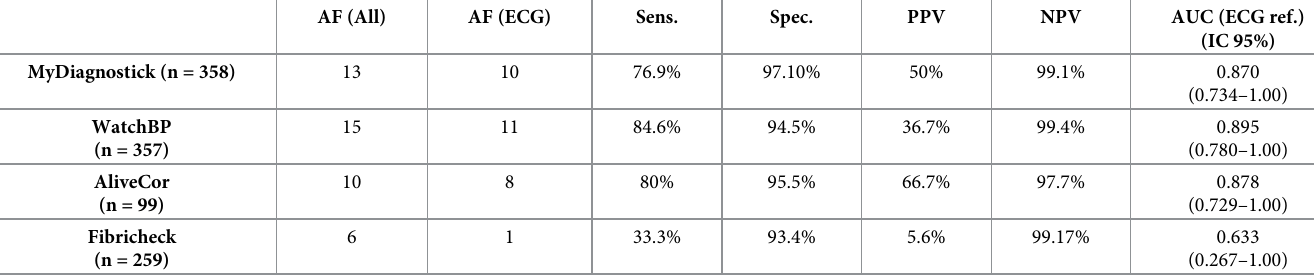
NPV: Negative predictive value; PPV: Positive predictive value. The first column indicates the number of AF from the total detected by each device (here we count AF cases detected by Holter monitoring). The second column indicates the number of AF from the ones detected by ECG, also detected by each device. Sensitivity, specificity, PPV, NPV and AUC were calculated using the ECG as a